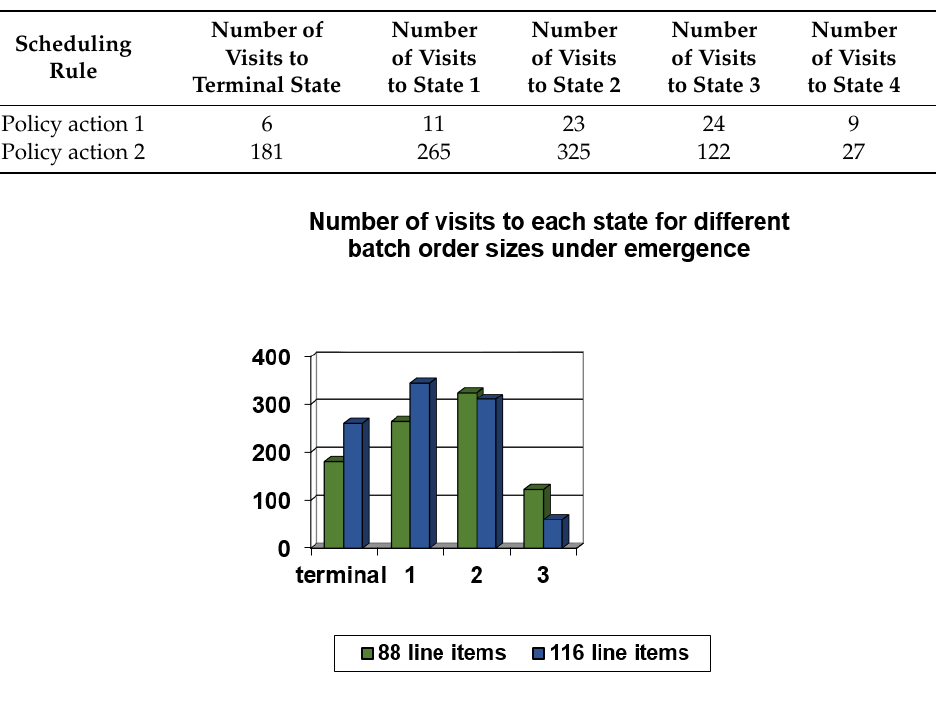
Table 9. Simulation results for the scheduling under emergence of one batch of 28 orders with mean order size three line items per order and four emergency orders. Q-learning was implemented with ε = 0.